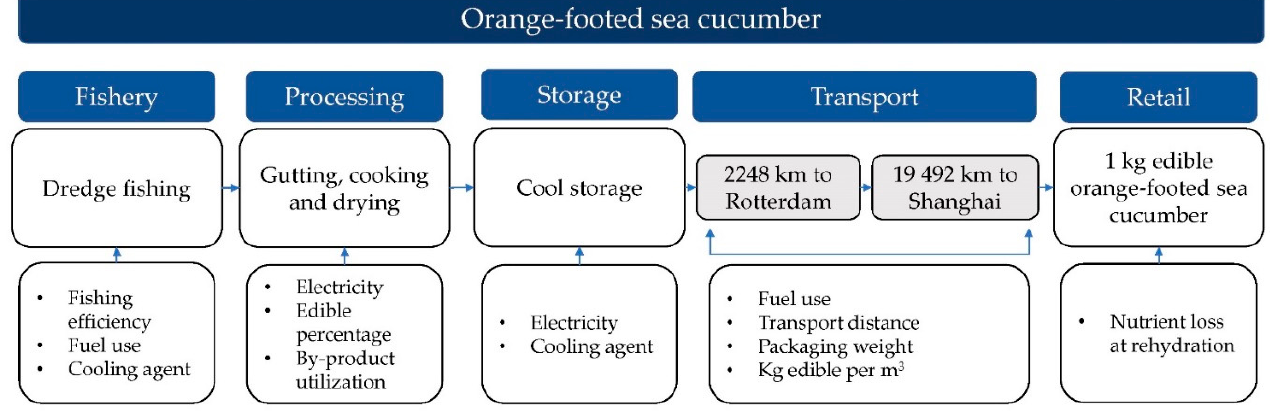
Figure 2. Flowchart of modelled production chain for orange-footed sea cucumber ( Cucumaria frondosa ) between cradle and retail gate (People’s Republic of